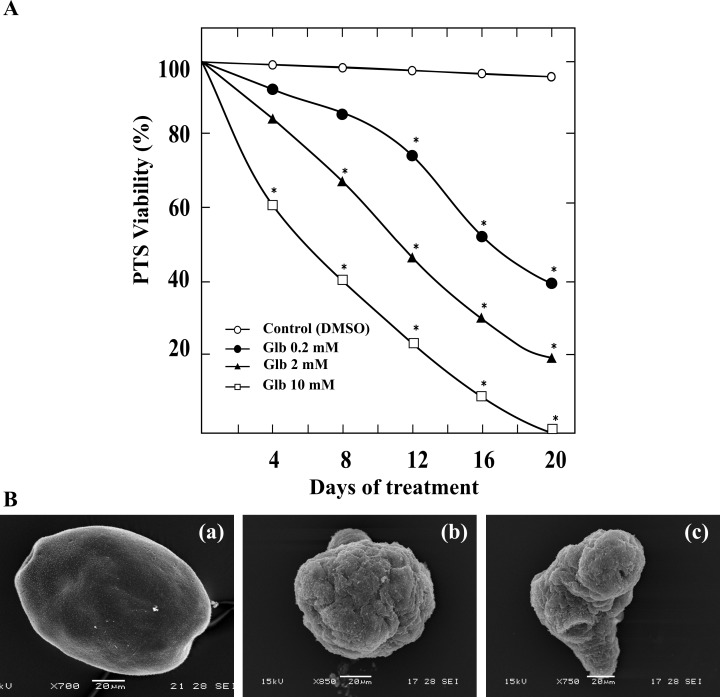
In vitro effect of glibenclamide on viability of E. granulosus protoscoleces.(A) Viability of protoscoleces incubated for 20 days with 0.2, 2 and 10 mM of glibenclamide (Glb). Parasites incubated in culture medium containing DMSO served as controls. The protoscolex viability was determined every two days by the methylene blue exclusion test (at least 100 protoscoleces per replica were counted each time). Data are the mean ± S.D. of three independent experiments. *Statistically significant difference (p < 0.05) compared with control. (B) Representative SEM images of control protoscoleces (a) or treated with 10 mM Glb for 7 days (b, c). (a) Invaginated control protoscolex; (b, c) Evaginated treated protoscoleces, with altered tegument in the soma region and loss of microtrichias on the escolex region. Bars indicate: 20 μm.